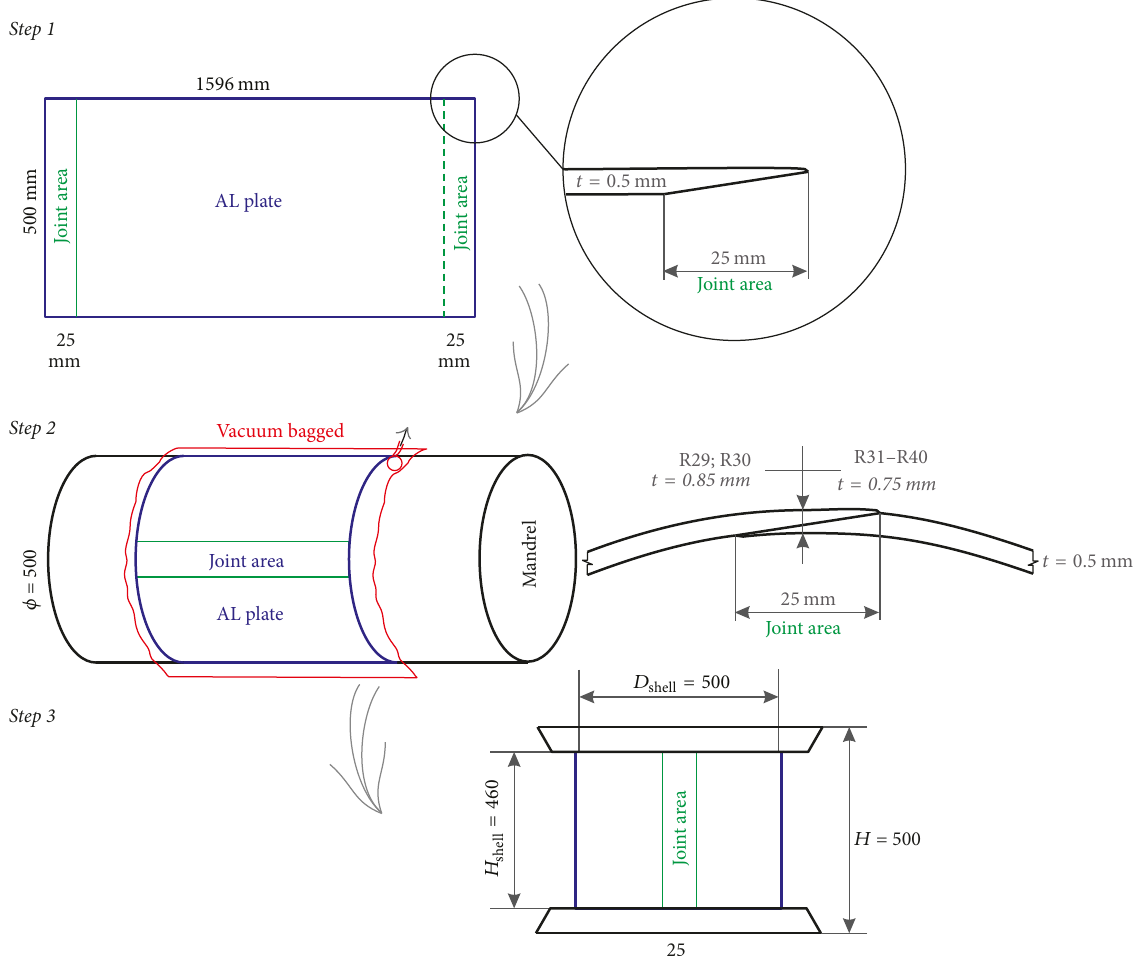
Figure 1: Subsequent stages for producing of an adhesively bonded overlap joint: tapering of both edges at the bonding line (Step 1 ); aluminium sheet wrapped around a cylindrical steel mandrel, vacuum-bagged with clamped joint area (Step 2 ); final assembly, cylindrical shell with edge casting blocks (Step 3 ). Table 1: Test